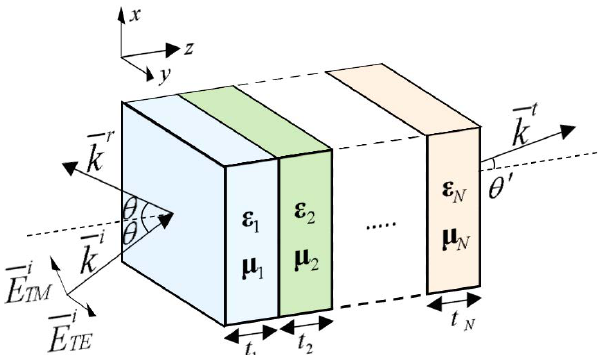
Figure 1: Geometry of the